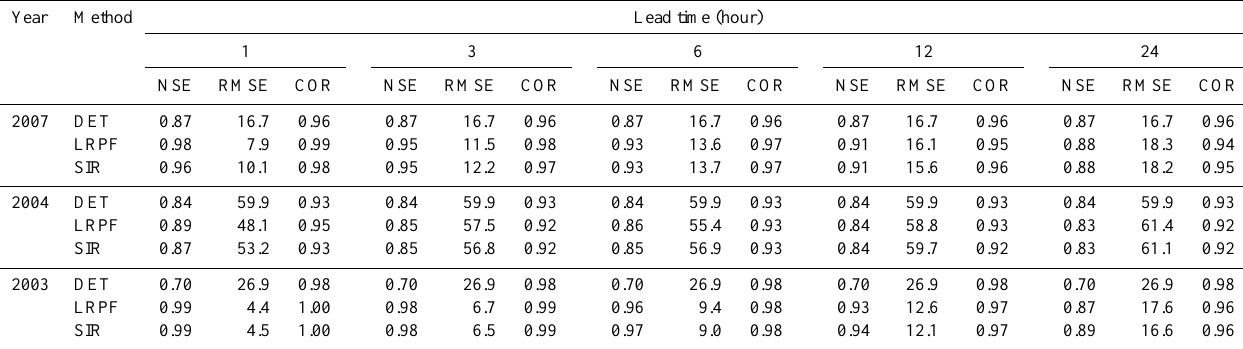
Table 2. Statistics of streamflow forecasts with varying lead times ( α soil